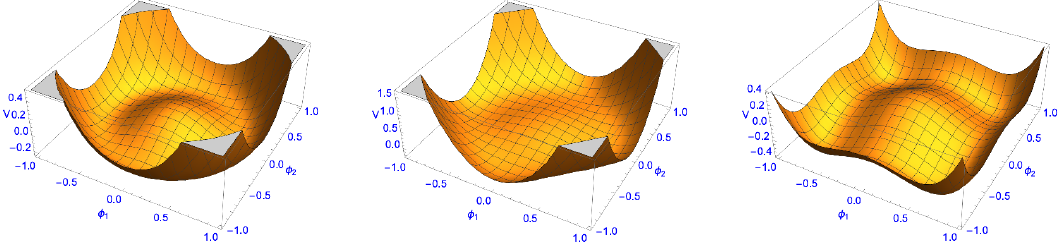
Figure 1 . Potential configurations in the φ 1 − φ 2 plane with three possible choices of λ 2 while keeping λ 0 . Left: λ = 0 ; middle: λ 0 and right: − 0 . 5 < λ 12 > 2 2 >